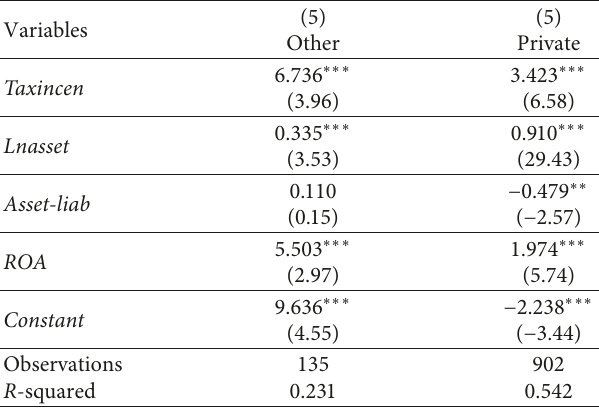
Table 5: Tax incentive policies-innovation input (property right)